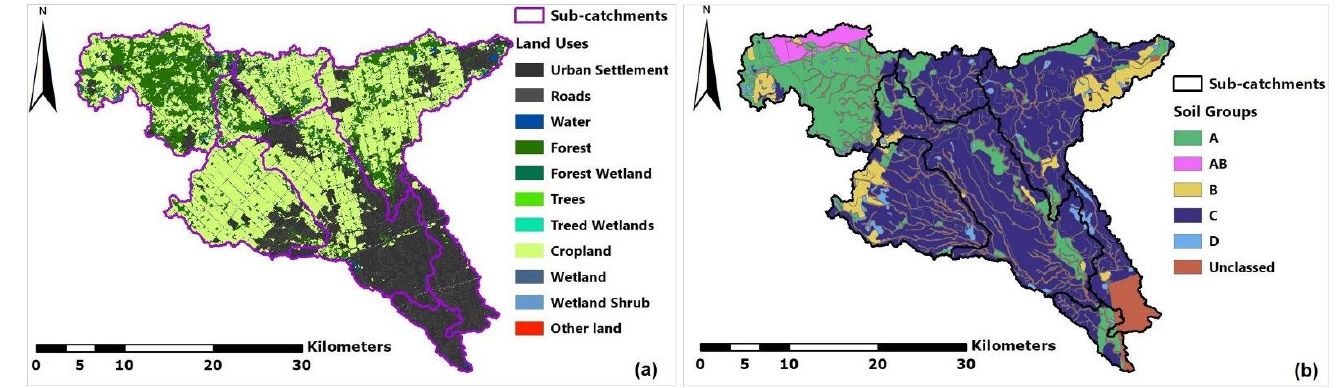
Figure 2. ( a ) Land uses and ( b ) soil groups of Humber River Basin. Base maps reprinted from Agriculture and Agri-Food Canada under Open Government License—Canada, vers. 2.0 (https://open.canada.ca/en/open-government-licence-canada, accessed on 11 May